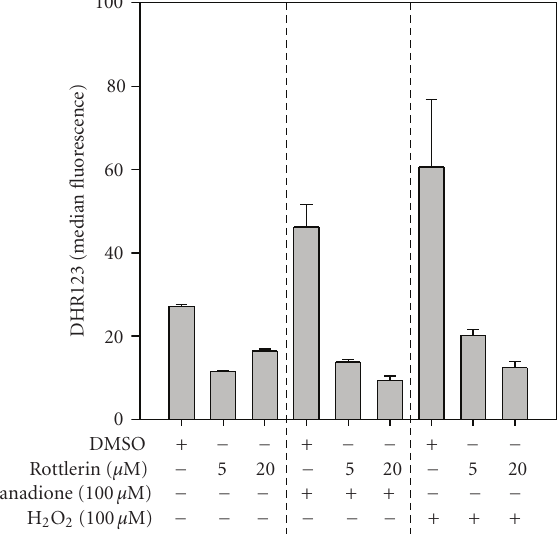
Figure 6: E ff ect of Rottlerin on NF κ B nuclear translocation and transcriptional activity in HT-29 transfected cells. HT-29 cells, stably transfected with the NF κ B-driven plasmid pBIIX-LUC, were pretreated for 30 min with 5 and 20 μ M Rottlerin and then treated with 10 ng/mL TNF α for 4 hr, before luciferase activity measurement. Data are the mean value ± SD of four independent